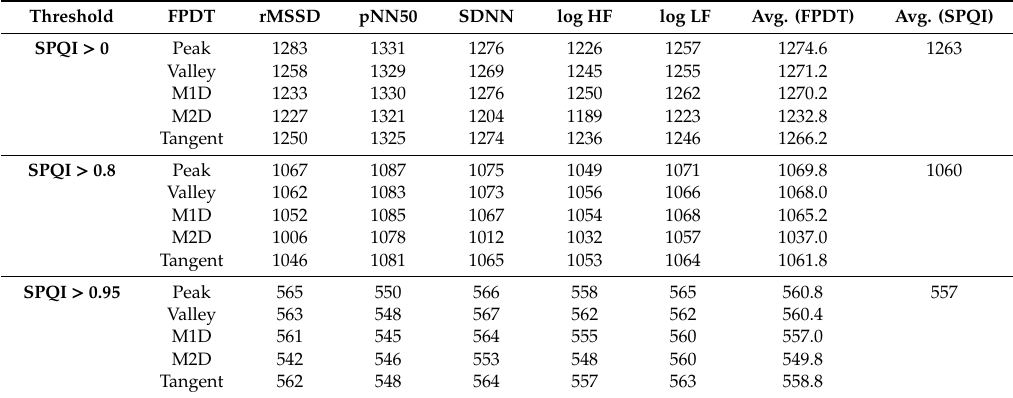
Table 4. Number of valid samples filtered by di ff erent smartphone PPG quality index (SPQI) levels.